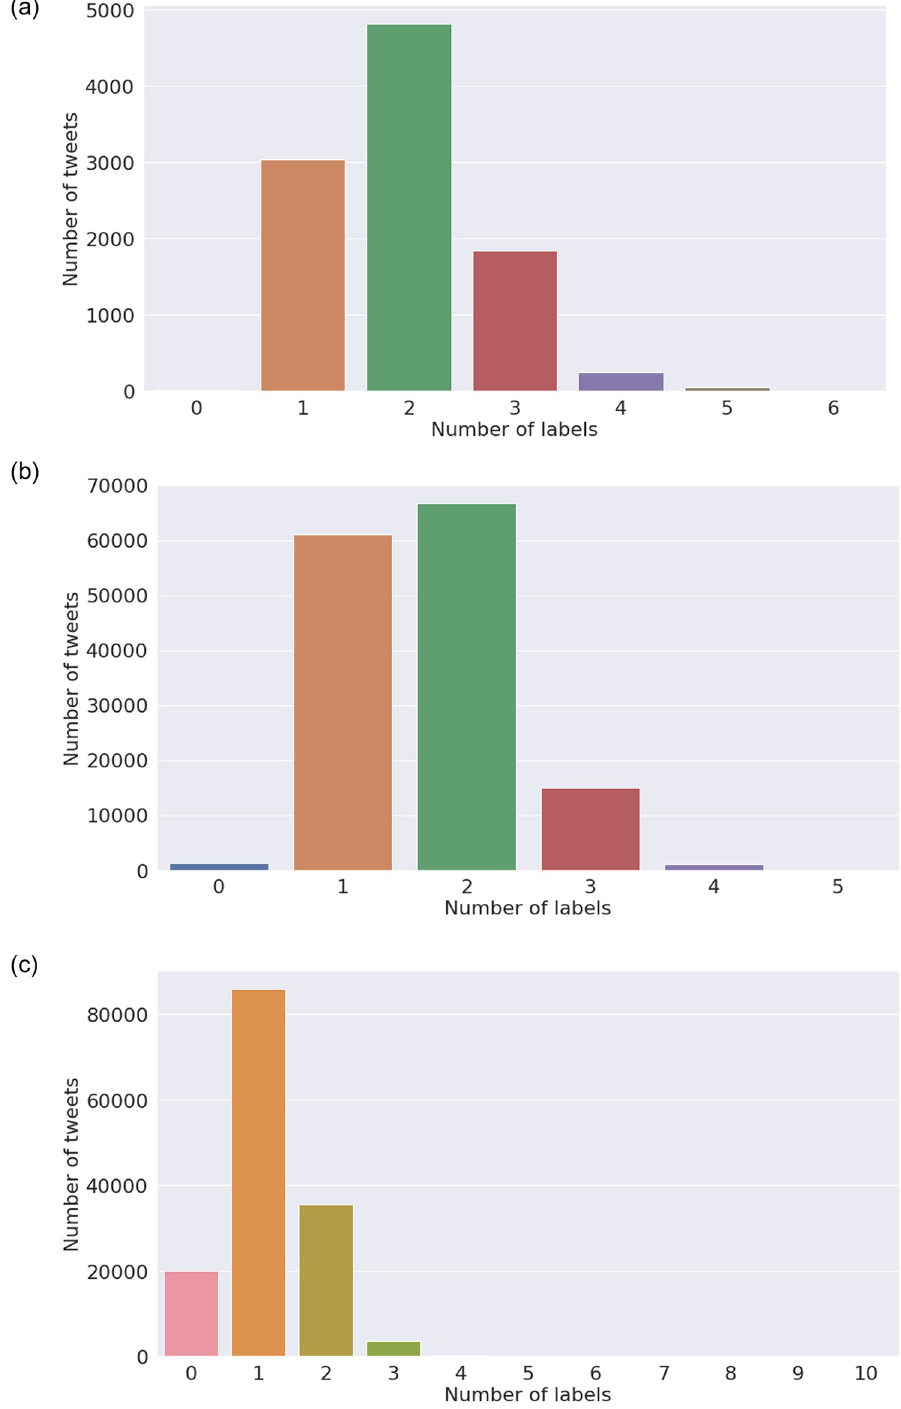
Fig 9. Distribution of tweets with number of combination of sentiment types (labels) for Senwave training dataset, and predictions by BERT and LSTM models. (a) Senwave hand-labelled sentiments (Worldwide). (b) Predicted (India) using BERT. (c) Predicted (India) using LSTM.